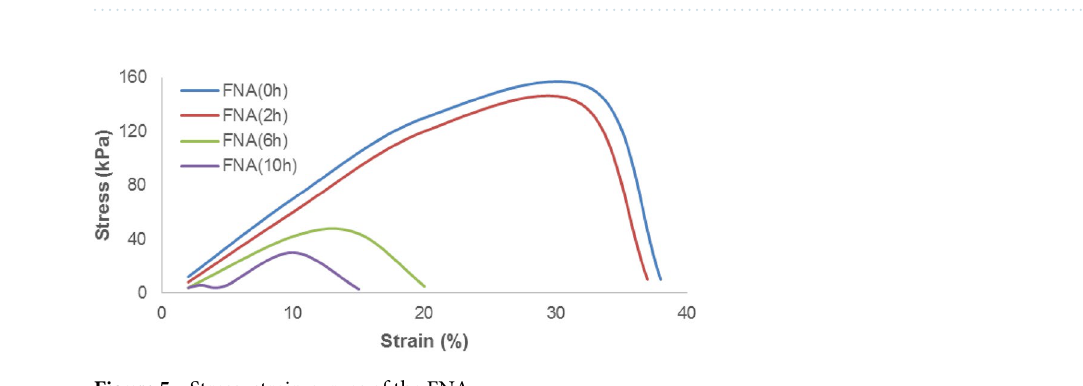
Figure 5. Stress–strain curves of the